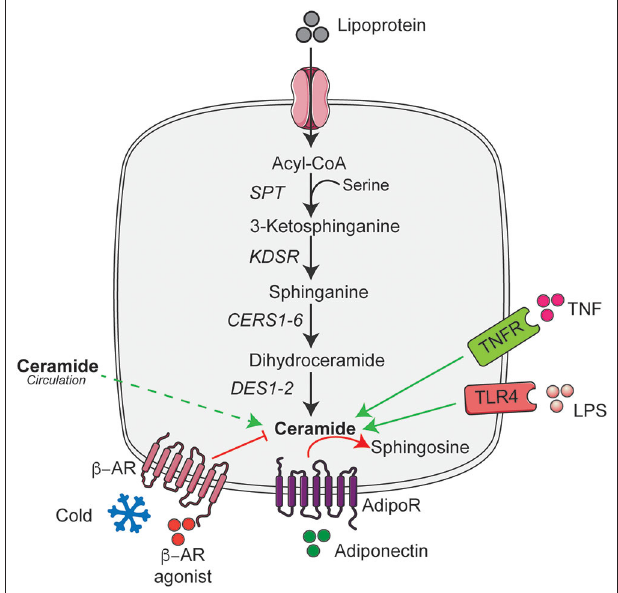
FIGURE 1 | De novo ceramide synthesis pathway and its hormonal regulators in adipose tissue. Schematic of the de novo ceramide synthesis pathway and regulators of ceramide synthesis discussed in the text. Black arrow indicates the key steps in de novo ceramide synthesis; solid green arrow indicates the factors that stimulate ceramide synthesis; dashed green arrow indicate the putative uptake and red arrows and lines indicate factors that reduce or metabolize ceramide. AdipoR, Adiponectin receptor; ASAH1, Acid ceramidase 1; β -AR, β -adrenergic receptor; CERS1-6, Ceramide synthase 1-6; DES1-2, Dihydroceramide desaturase 1-2; KDSR, 3-ketodihydrosphingosine reductase; LPS, Lipopolysaccharide; SPT, Serine palmitoyltransferase; TLR4, Toll-like receptor-4; TNFR, Tumor necrosis factor receptor. This figure was drawn using the Servier